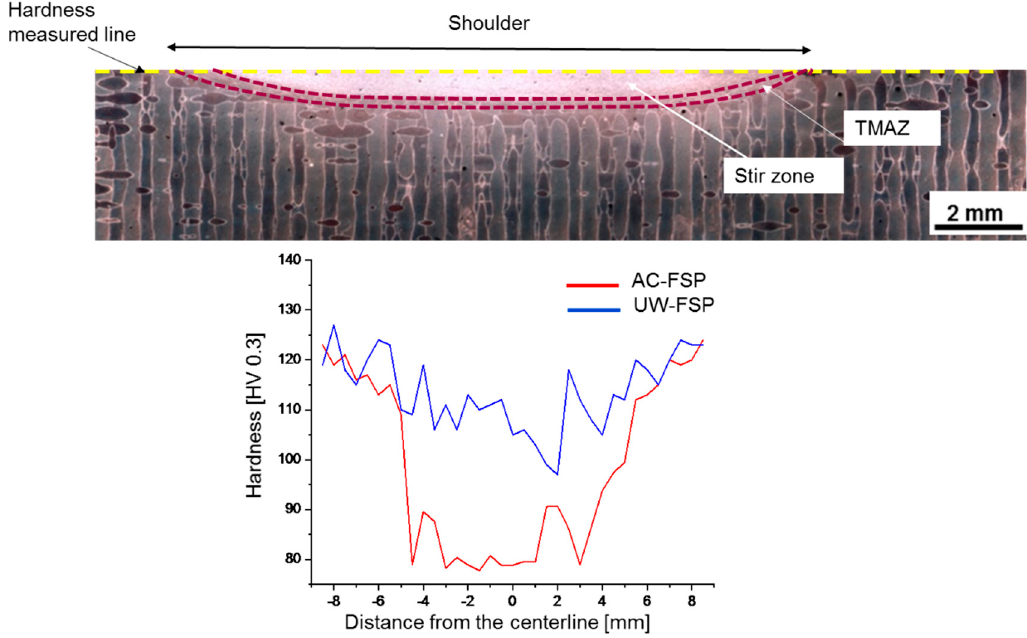
Figure 3. Hardness distribution along the FSP treated surfaces in AC-FSP and UW-FSP conditions.